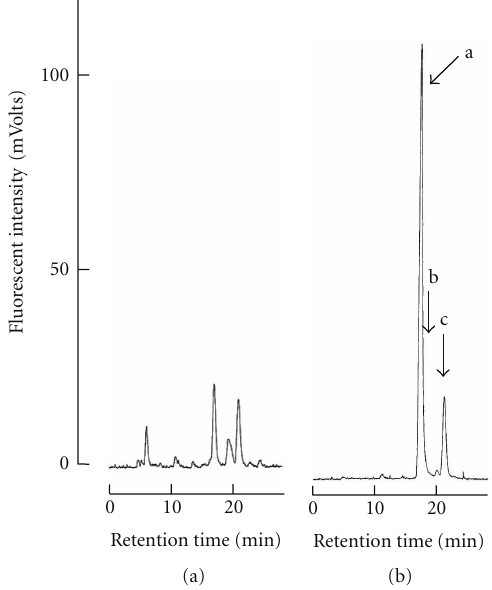
Figure 3: HPLC-FLD analysis of TTX in D. cultripes . One MU of TTX standard solution was injected to HPLC-FLD system. (a) Viscera. (b) TTX standards. (a: TTX; b: 4- epi TTX; c: 4,9-